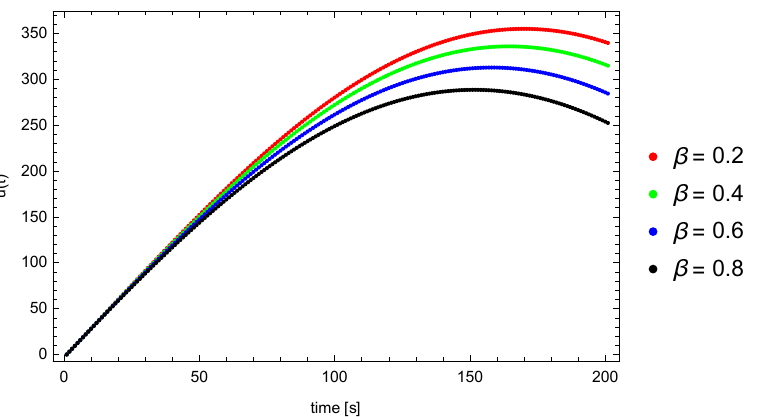
Figure 9. Values of the function u at point K 4 for different values of the parameter β ( α = 0.8, c = 900).